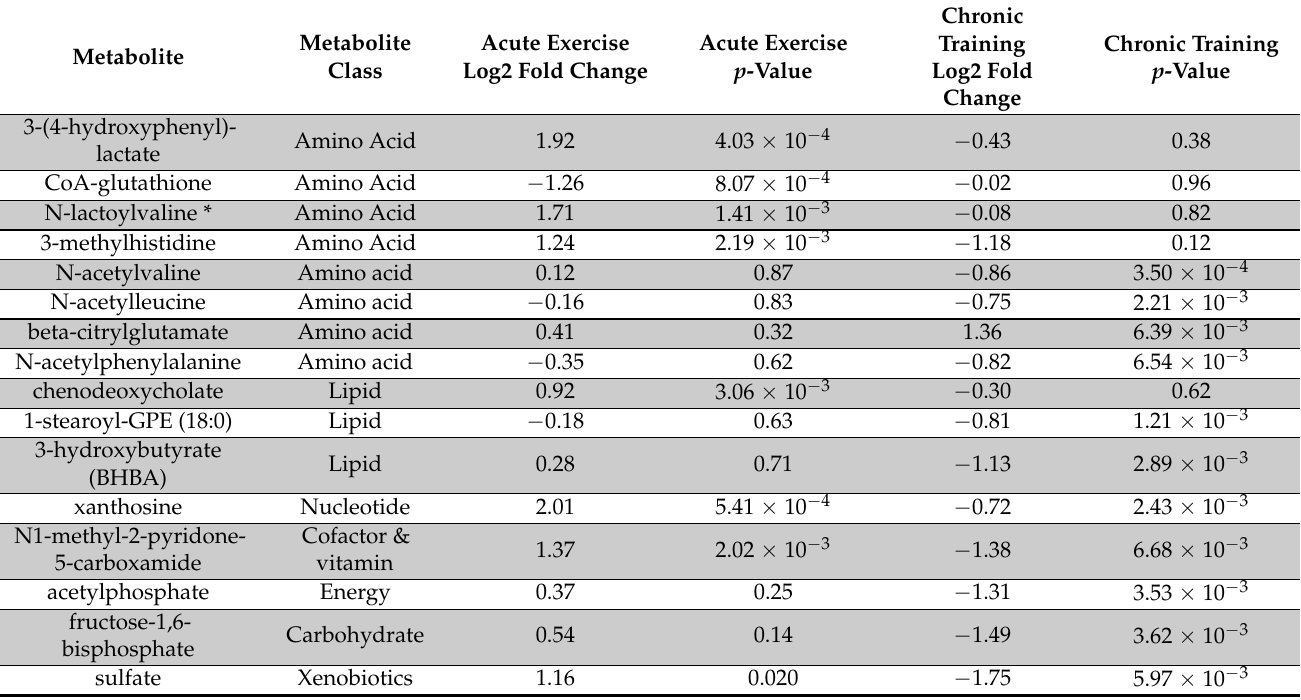
Table 1. Metabolites with significant changes after acute exercise and/or chronic training. Bold font indicates significance controlled by false discovery rate; provided p -values are